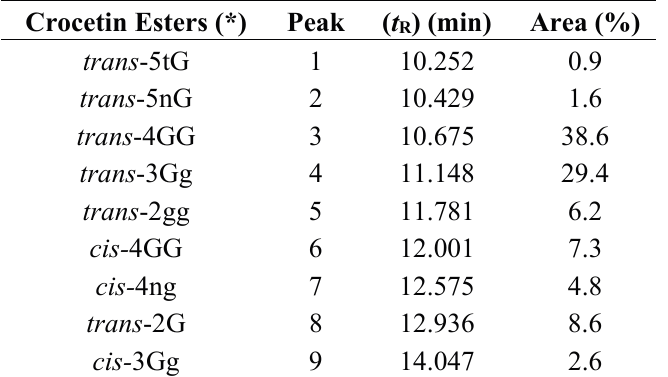
Table 1. Peak number, retention time ( t R ) and area percentage each chromatographic peak corresponding to crocetin esters (crocins) identified in the pool of crocetin esters. Crocetin Esters